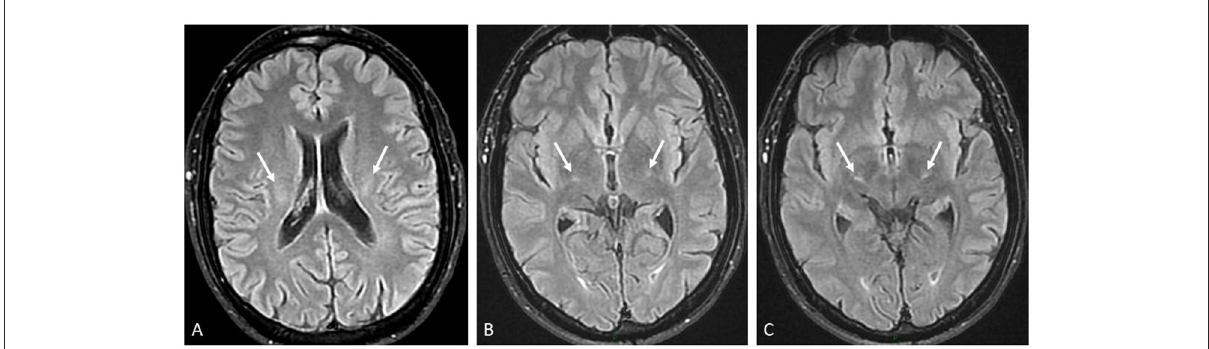
FIGURE2 Brain MRI workup. Three axial transverse FLAIR views from the top to bottom showing moderate and symmetrical hypersignal intensity of the corticospinal tract (arrows) at the levels of the following: (A) the corona radiata, (B) the posterior arm of the internal capsule, and (C) the thalamo-mesencephalic junction.